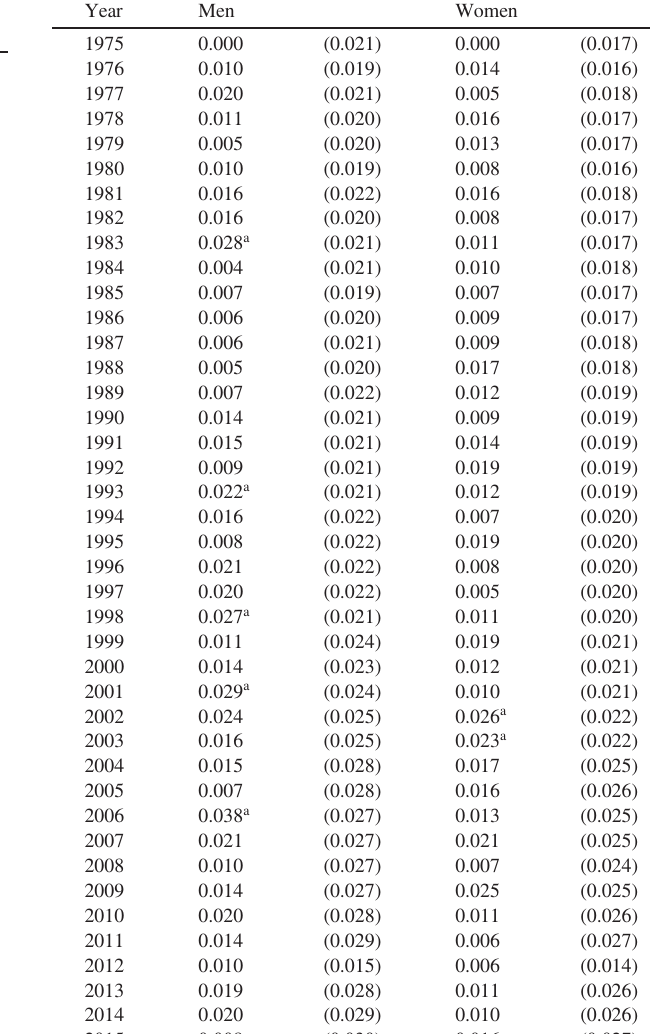
Table 3. Test statistics (critical values) of the Kolmogorov – Smirnov test on the di ff erence between body mass index distributions observed in the survey and those simulated by the system dynamics model